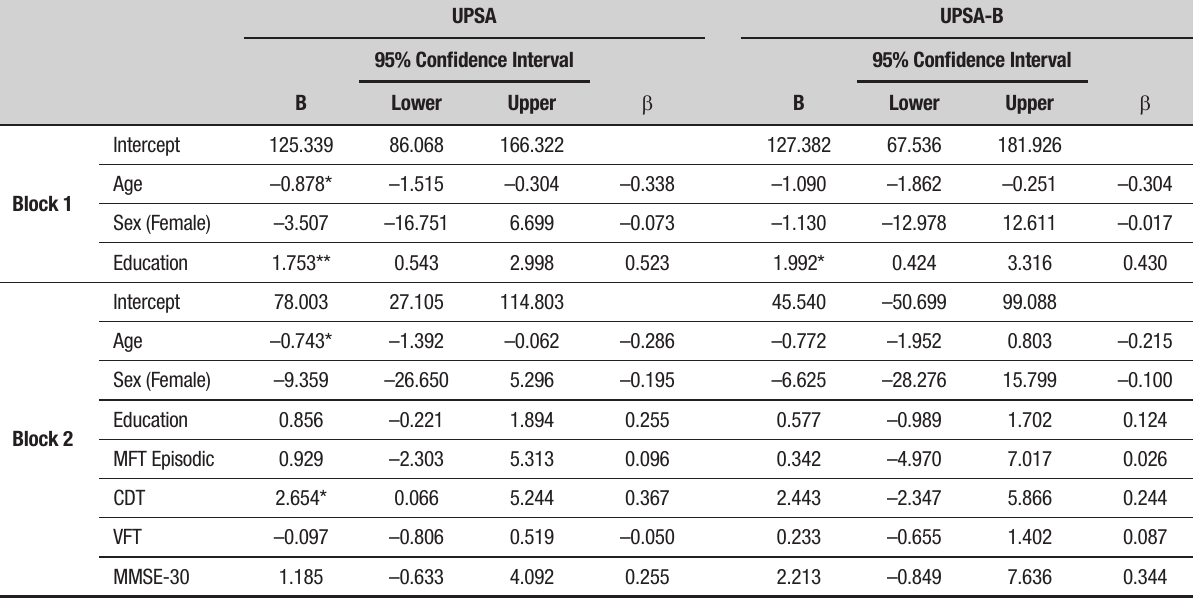
Table 3. Regression models with demographic and cognitive variables predicting UPSA and